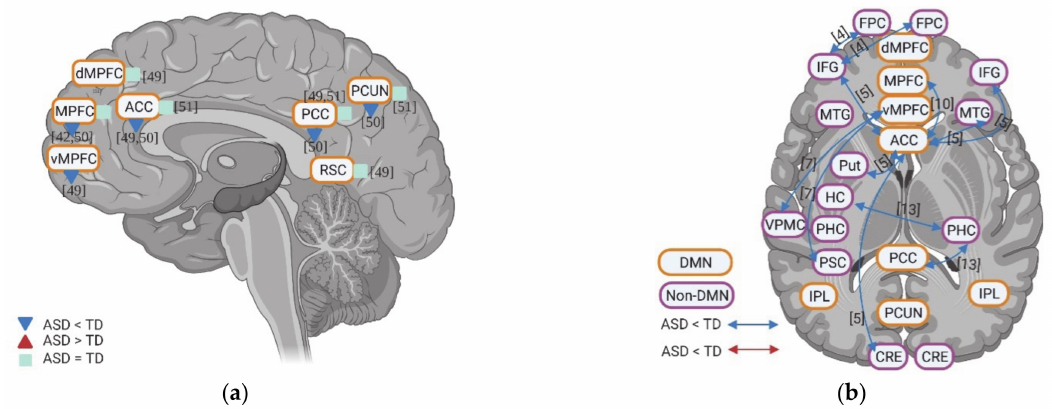
Figure 2. ( a ) Deactivation of DMN for individuals with ASD compared to TD during self-specific tasks in contrast with resting states. The numbers in the figure correspond to the study numbers in Table 2. ( b ) Functional connectivity within DMN and between DMN and non-DMN regions for individuals with ASD compared to TD during self-specific tasks. The numbers in figure correspond to the study numbers in Table 1.